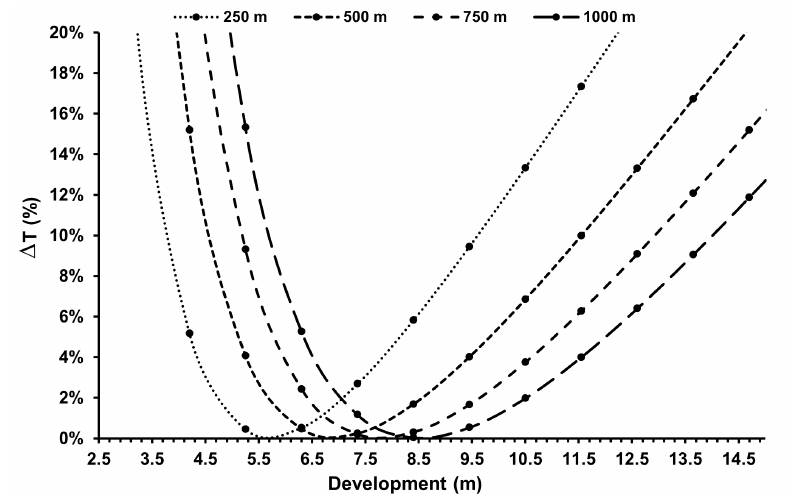
Figure 11. Change in the calculated run-time ∆ T of the generic athlete as a function of development for distances from 250m to 1000m.